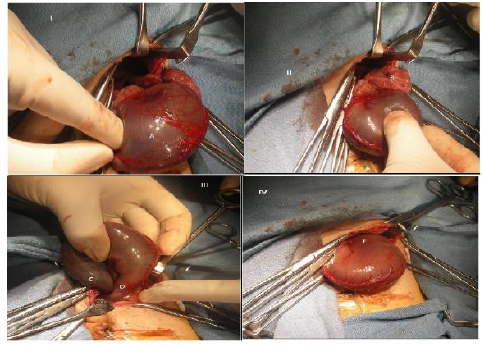
Figure 2: Intra-operative images showing closed loop obstruction with distended and congested stomach (I-A)) with small bowel herniating above the stomach (II-B). Mesentro-axial type of volvulus just prior to detorsion (III) with gastro-esophageal junction(C) on right side and pyloro-duodenal junction on left side (D). Post-detorsion, (IV) normal anatomy being restored with reduced distension and